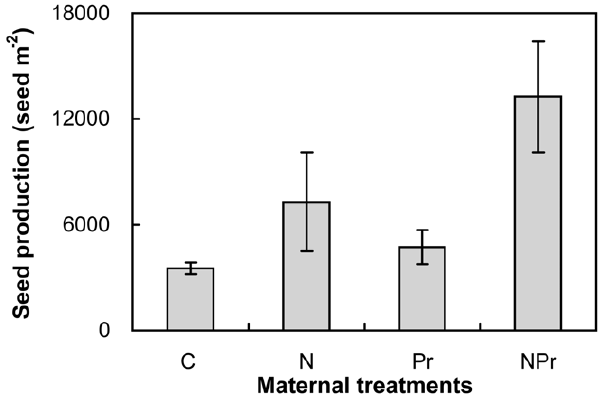
Figure 1. Effects of maternal-treatments on seed production of Potentilla tanacetifolia. Data are mean 6 SE (n=4). C: control